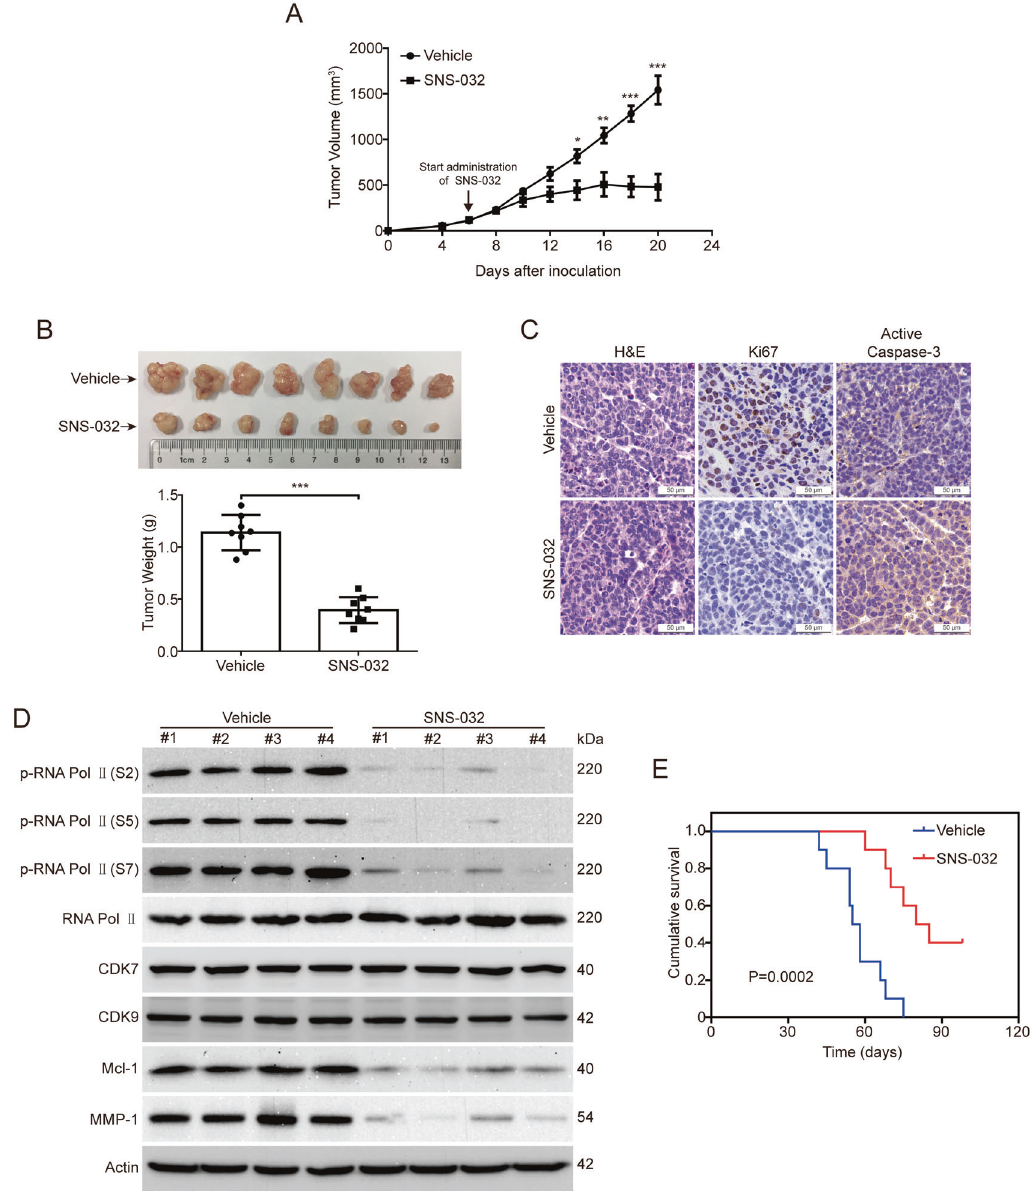
panel) of isolated tumors derived from mice of each group are shown. *** P < 0.001, by Student ’ s t test. C H&E and IHC staining of xenograft tissues with anti-Active Caspase-3 (apoptosis marker) and anti-Ki67 (proliferation marker) from vehicle- or SNS-032-treated mice are